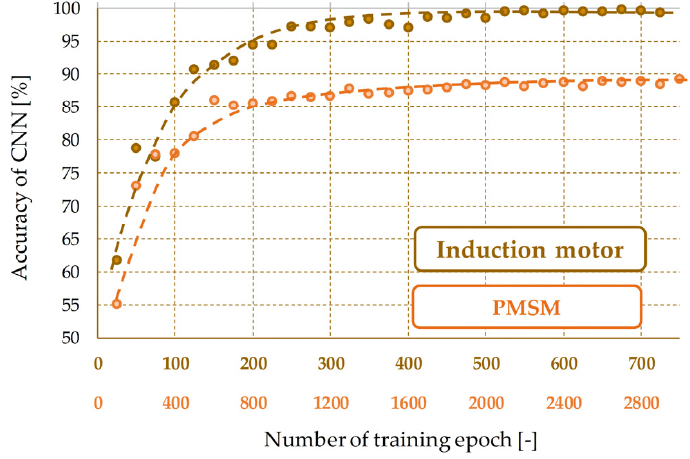
Figure 12. Influence of the number of learning epochs on the precision of a diagnostic system. The courses of dependence of the precision of diagnostic systems on the number of training epochs presented in Figure 12 show that after reaching 400 and 1600 epochs, respectively, for CNN-IM (CNN-based diagnostic system for IM) and CNN-PMSM (CNN- based diagnostic system for PMSM), a clear stabilization of the precision level occurs. An excessive increase in the number of learning epochs does not disturb the operation of the network. Moreover, due to the use of the techniques of normalization, rejection, and training based on a randomly created mini-batch of data, the risk of overmatching with the training data is minimized. However, during the practical implementation of CNN, in addition to analyzing the effectiveness of the network for training, validation, and final testing data, it is advisable to observe changes in the course of the loss function in each training epoch. Such an approach will make it possible to interrupt the learning process after achieving the assumed precision or, more importantly, during a sudden increase in the value of the loss function for validation data. A particularly important parameter of the CNN training process, which ensures the appropriate dynamics of the learning process and its convergence, is the initial value of the learning constant (Figure 13a). Due to the inability to accurately determine the value of this constant, the drop period technique is often used before starting the training process. The study used a 5% decrease in the value of the learning constant for a variable period (Figure 13c). In order to determine the impact of the learning constant and the period of its decrease, both the change in the level of precision of the CNN (Figure 13a,c) and the impact on the course of the training process (Figure 13b,d) were